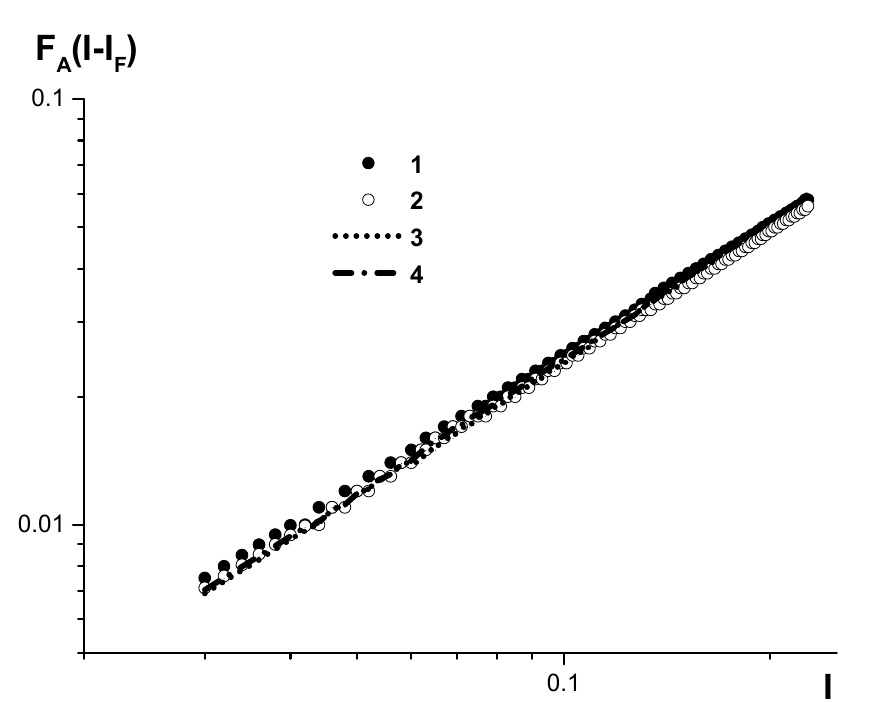
Figure 5. Calibration curves, plotted by the developed algorithm with accurate accounting for plasma background, to determine carbon concentration in low- and medium-alloyed steels on SPAS-02 and SPAS-05 emission spectrometers in the low concentration range (0.005–0.05%). The curves are plotted for: 1-SPAS-05 serial no. 18; 2, 3, 4-SPAS-02 serial numbers 22, 25, 26.